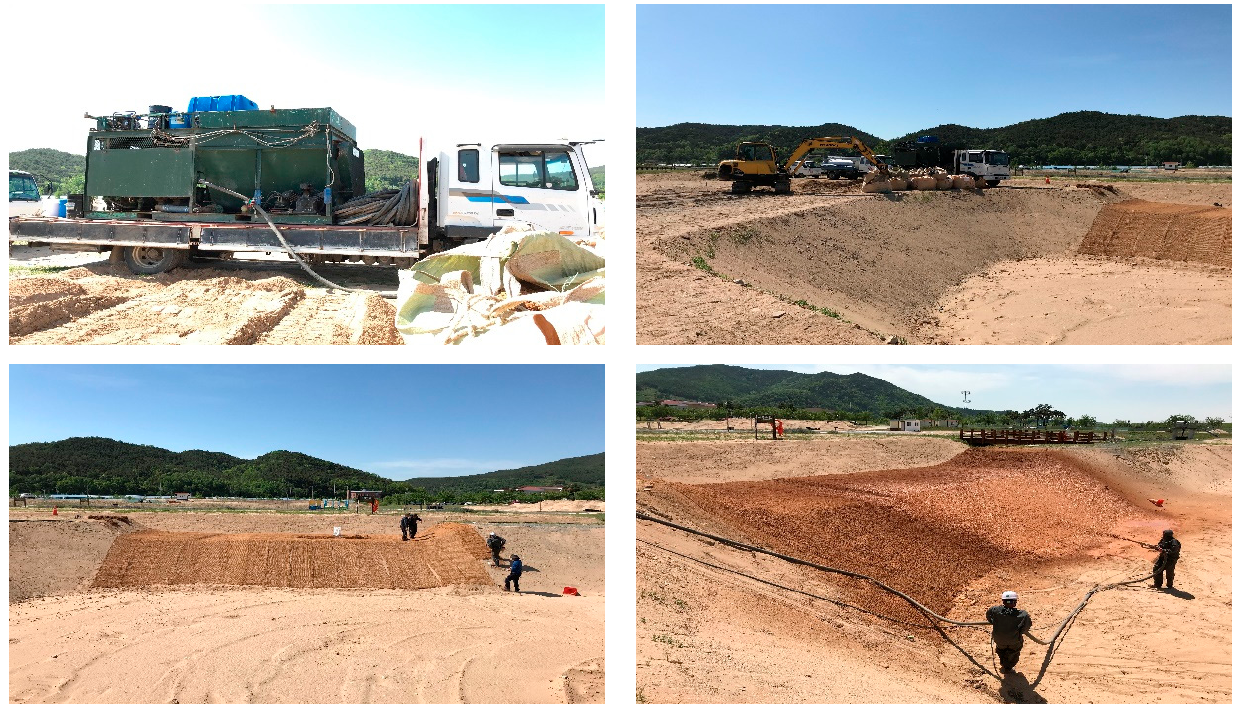
Figure 3. Application of the new material onto the surface of the levee using the wet spray method.